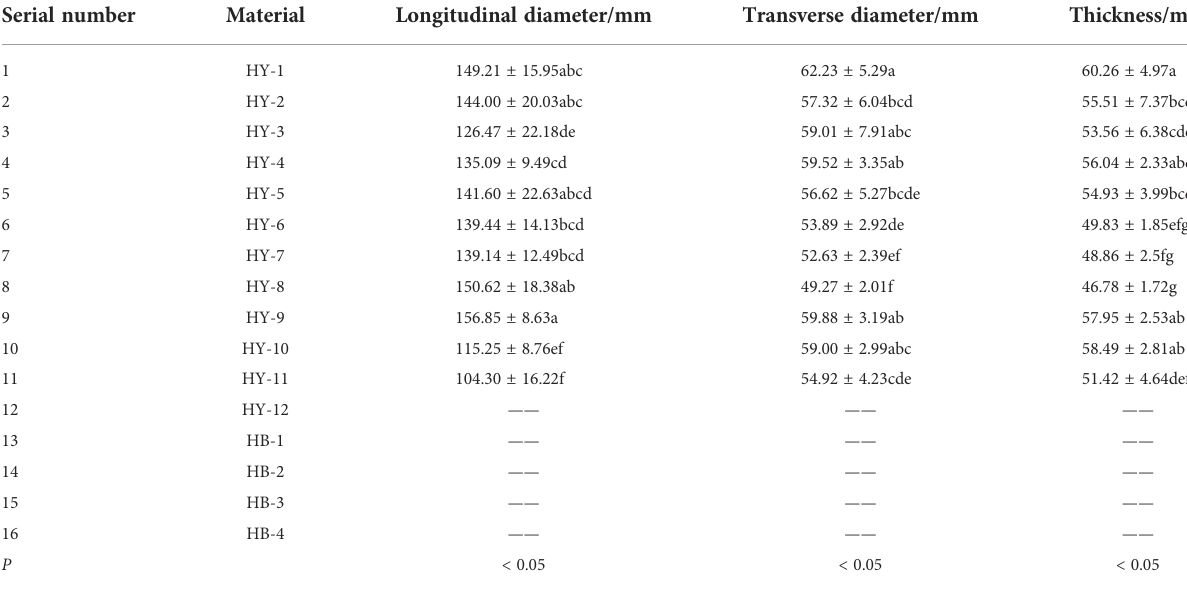
TABLE 1 Fruit shape parameters of different genotypes of A. trifoliata